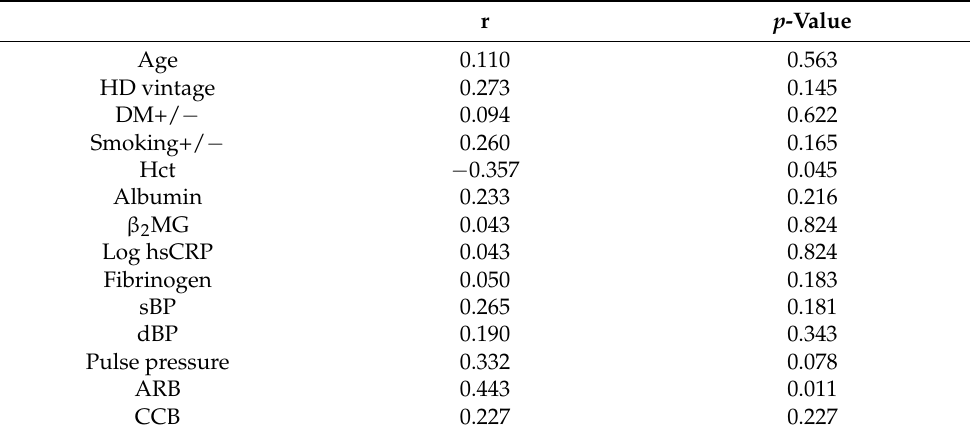
Table 5. Univariate regression analysis for maximal velocity of left MCA.